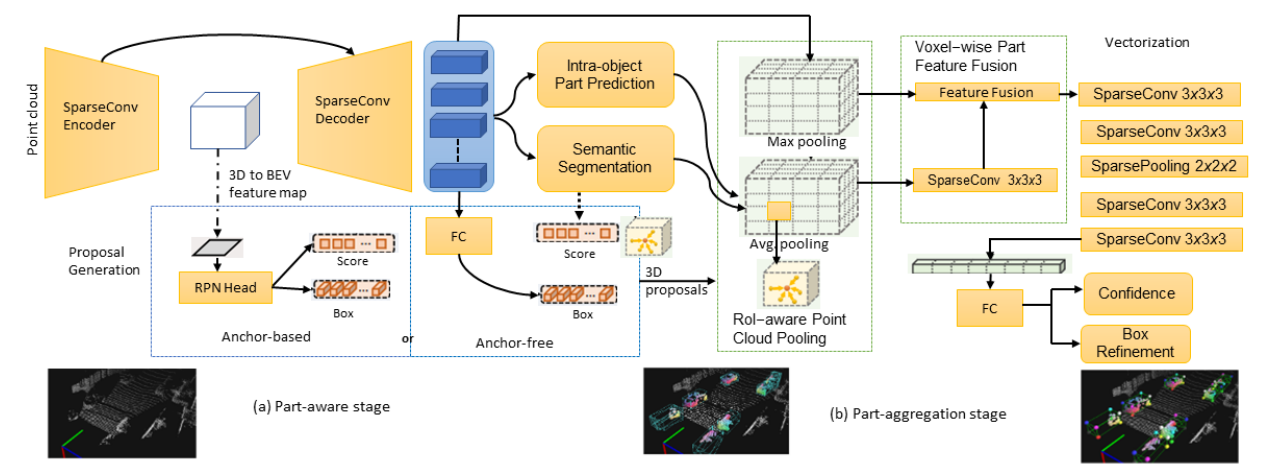
Figure 7. The part-aware and aggregation proposed 3D object-detection network architecture [113]. The model consists of two parts: ( a ) The intra-object part locations are predicted by the part-aware network. Then, 3D proposals are generated before feeding to the encoder-decoder network. ( b ) ROI- aware pooling is undertaken in the part-aggregation